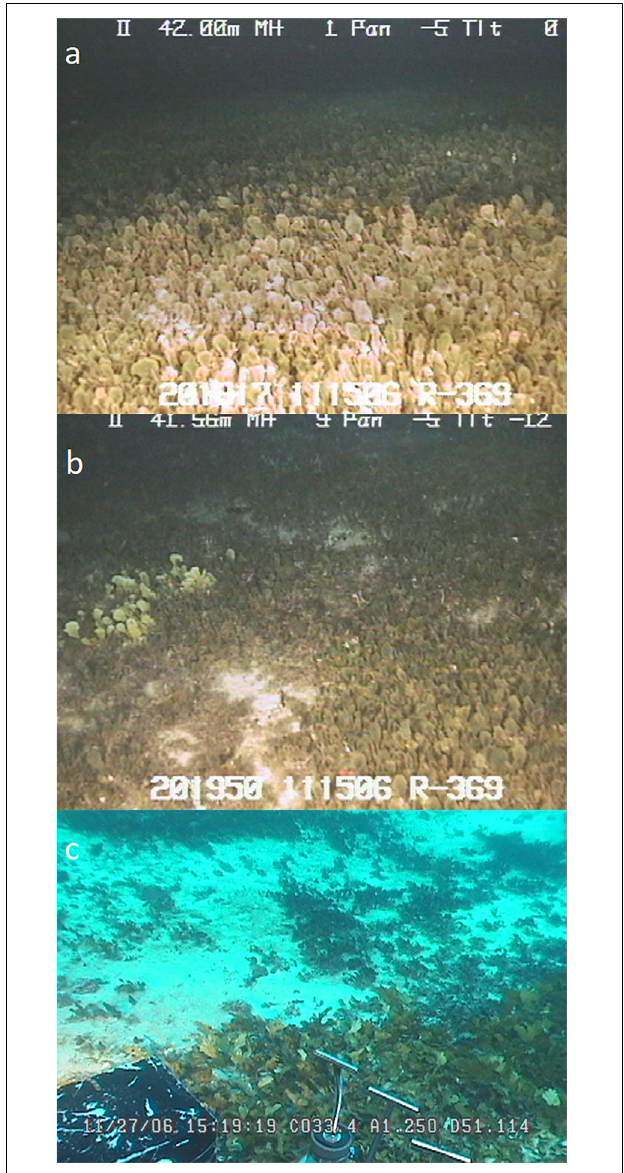
FIGURE 1 | (a) Video still of dense A. amadelpha meadow off the coast of southwest Oahu observed during submersible dive RCV-369. Video stills of A. amadelpha overtaking the lime green blades of native Udotea alga. Dives RCV-369 (b) and P4-188 (c) were conducted off the southwestern and southern coasts, respectively, of Oahu. All stills were taken at depths of 40–50 m in the upper mesophotic zone in November 2006.